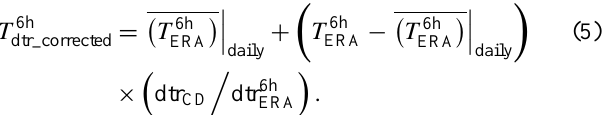
were established through comparison between